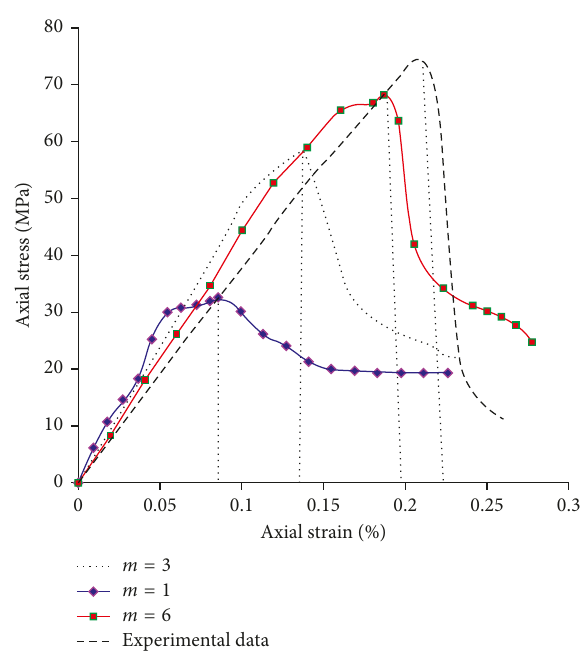
Figure 13: The total envelope of the stress-strain curves for three numerical specimens with different homogeneity indices and ex- perimental result.